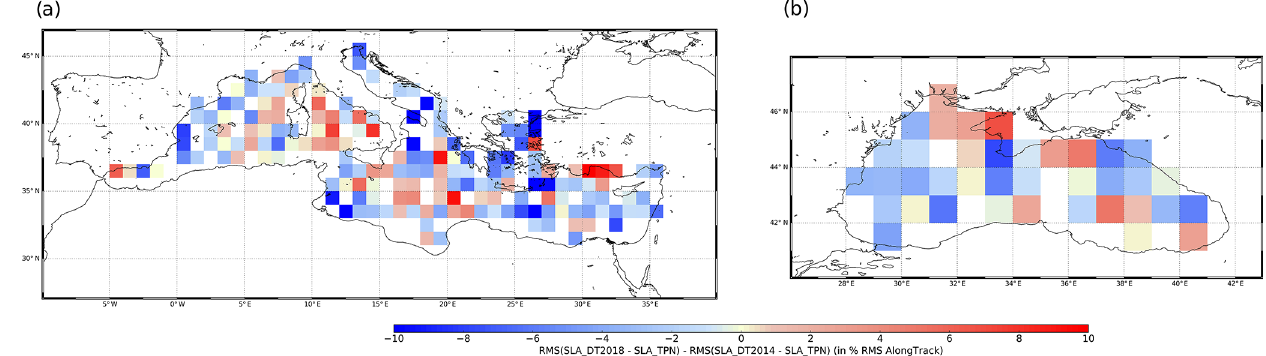
Figure 9. Difference of the RMS of the difference between gridded regional Mediterranean Sea (a) and regional Black Sea (b) SLA prod- ucts and independent TOPEX–Poseidon interleaved along-track SLA measurements successively using the DT2018 and DT2014 versions. Negative values represent reduced differences between DT2018 altimetry products and independent along-track measurements. The statistic is expressed as a percentage of the RMS of the independent along-track product.